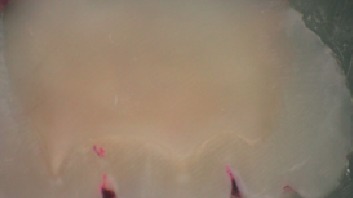
Slightly moistened bonding surface.